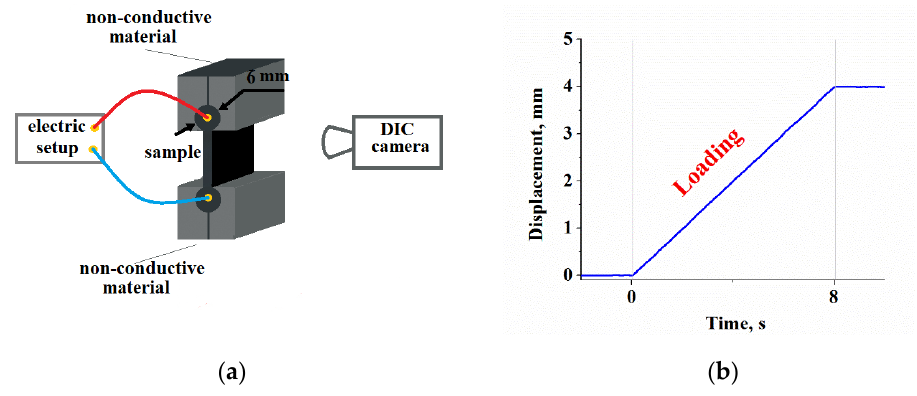
Figure 2. ( a ) Customized nonconductive clamps; ( b ) testing protocol.